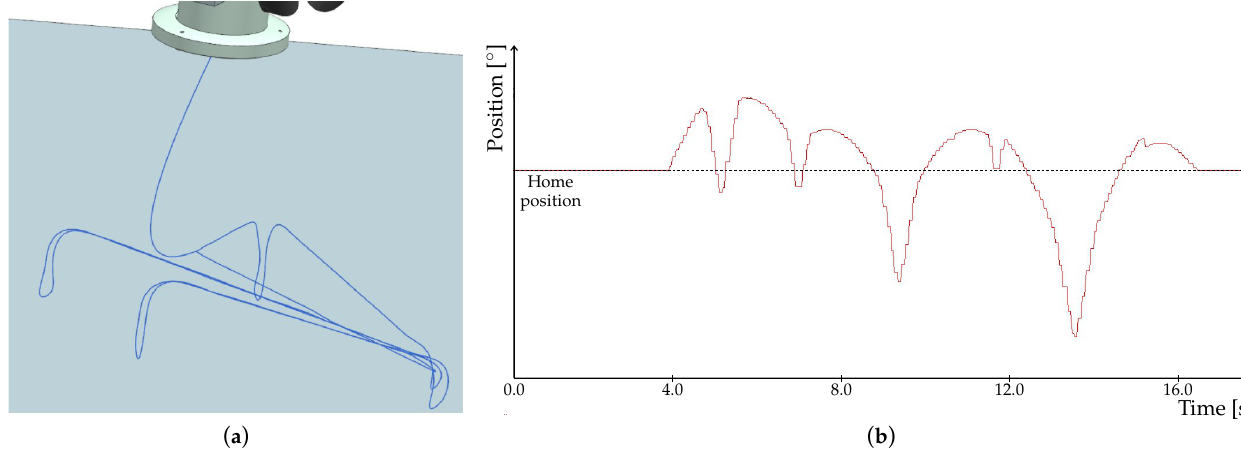
Figure 12. Results from simulation in NX MCD using PLC OPC UA server. ( a ) Trace of the tool. ( b ) Time profile of the signal adapter for axis position control.